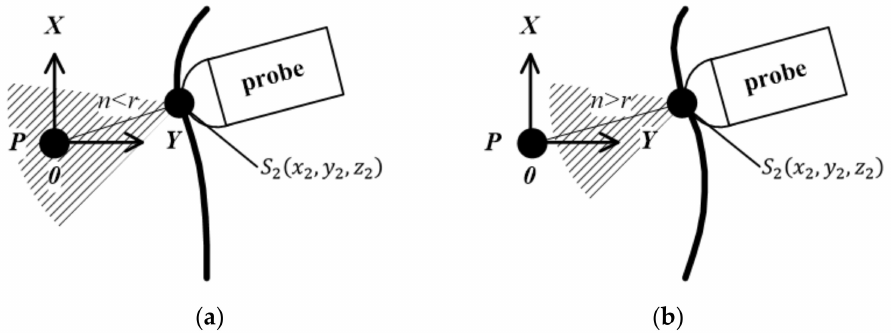
Figure 2. Surface of the target changes: ( a ) Distance less than the radius; ( b ) Distance is greater than the